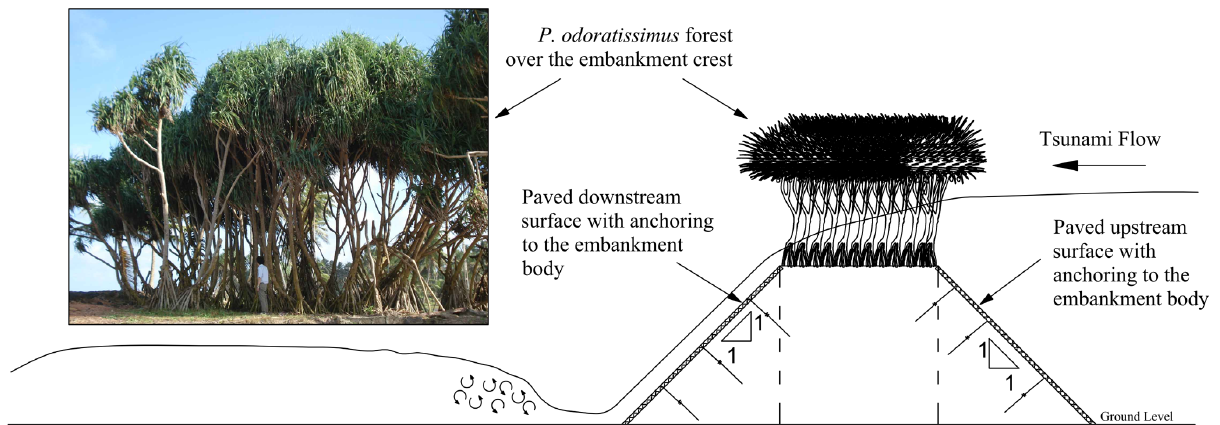
Figure 1. Schematic diagram of proposed hybrid mitigation measure of embankment with vegetation over the crest.